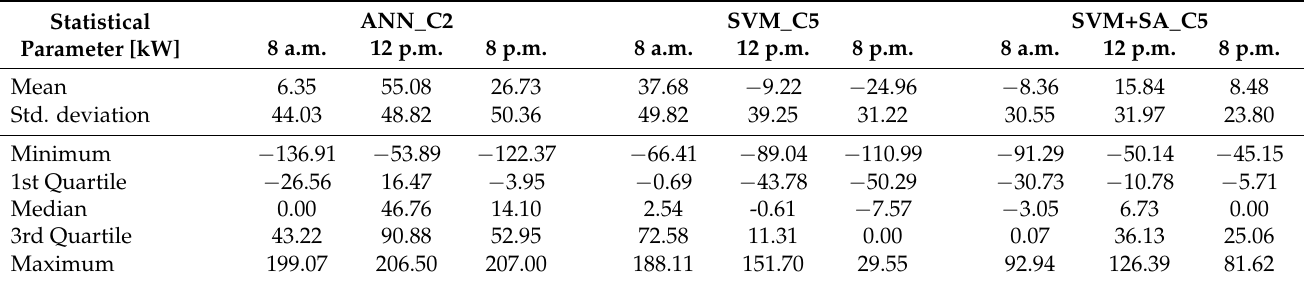
Table 3. Statistical parameters for cooling energy demand error.